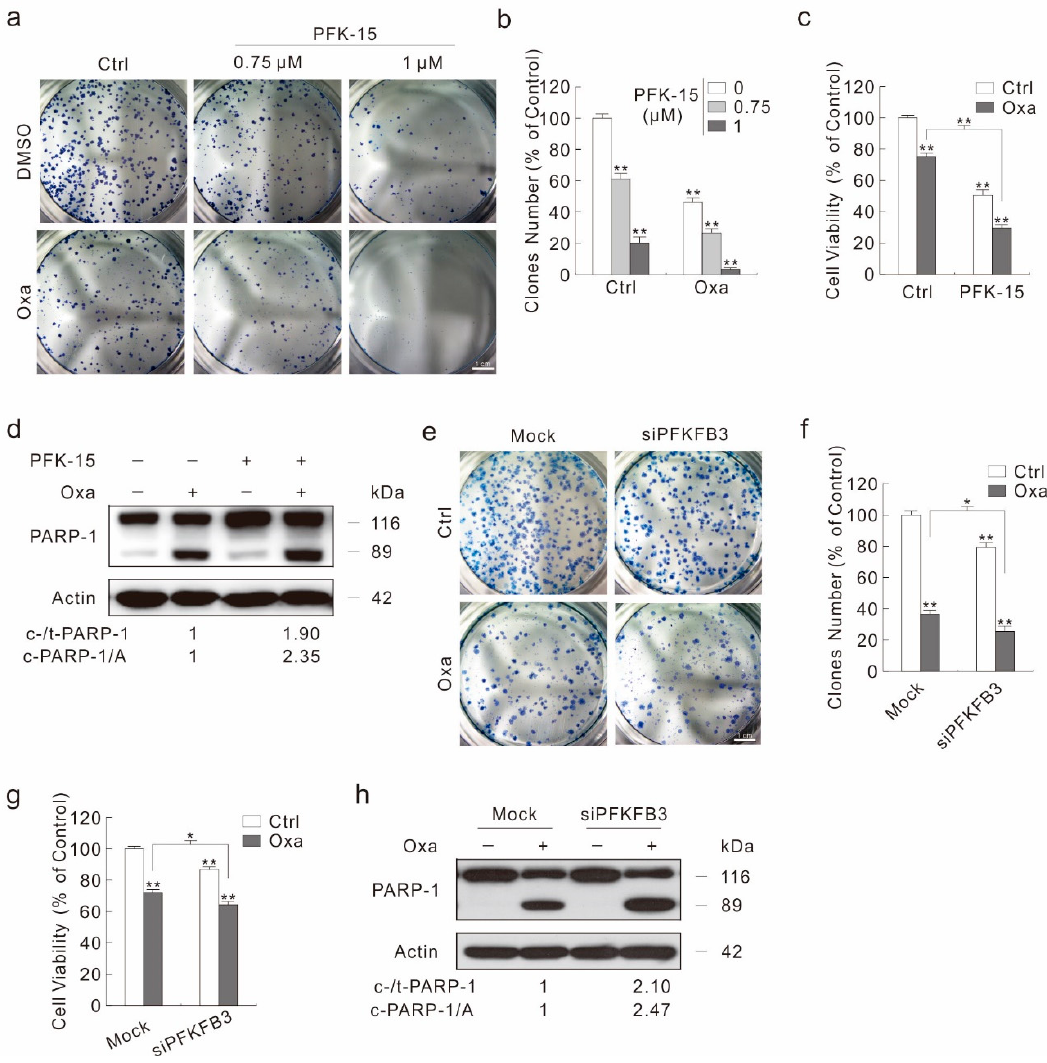
Figure 5. PFKFB3 inhibition enhances the cytotoxicity of Oxa. ( a , b ) Colony growth assay was performed with Oxa (1.5 μ M) in the presence or absence of PFK-15. ( c , d ) Cell viability was analyzed by MTS assay following the treatment with Oxa in the presence or absence of PFK-15 for 24 h ( c ); cell lysates from cells treated same as ( c ) were subjected to immunoblotting with indicated antibodies ( d ). ( e – h ) SW480 cells were transfected with the PFKFB3 siRNA or control siRNA for 48 h. Colony growth assay was performed with Oxa (1.5 µ M) ( e ), and relative clones number to control was shown in ( f ). Cell viability was analyzed by MTS assay following the treatment with Oxa for 24 h ( g ). Cell lysates were subjected to immunoblotting with indicated antibodies following treatment with Oxa for 24 h ( h ). For histogram graph data, * p < 0.05 vs. control, and ** p < 0.01 vs. control. Similar experiments were repeated three